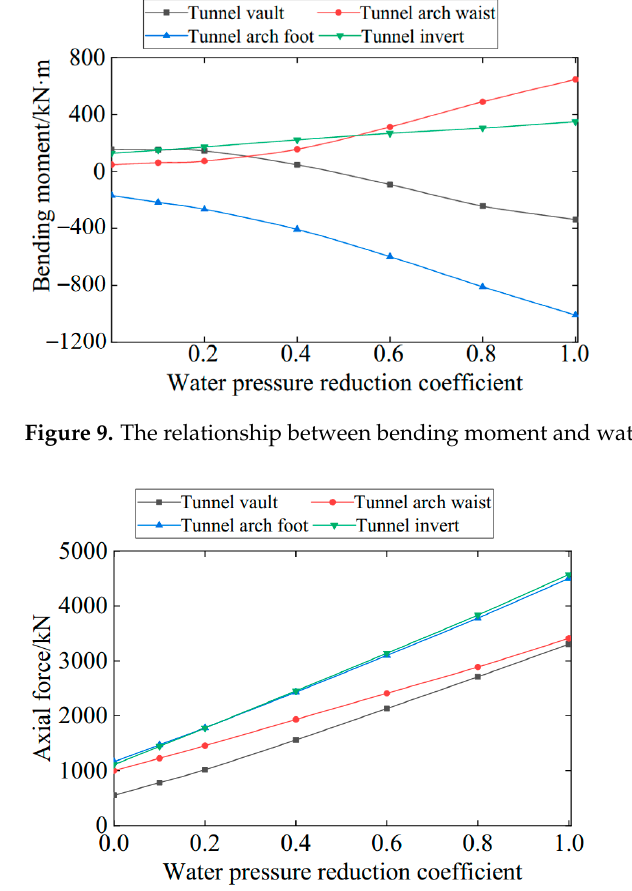
Figure 10. The relationship between axial force and water pressure reduction coefficient.